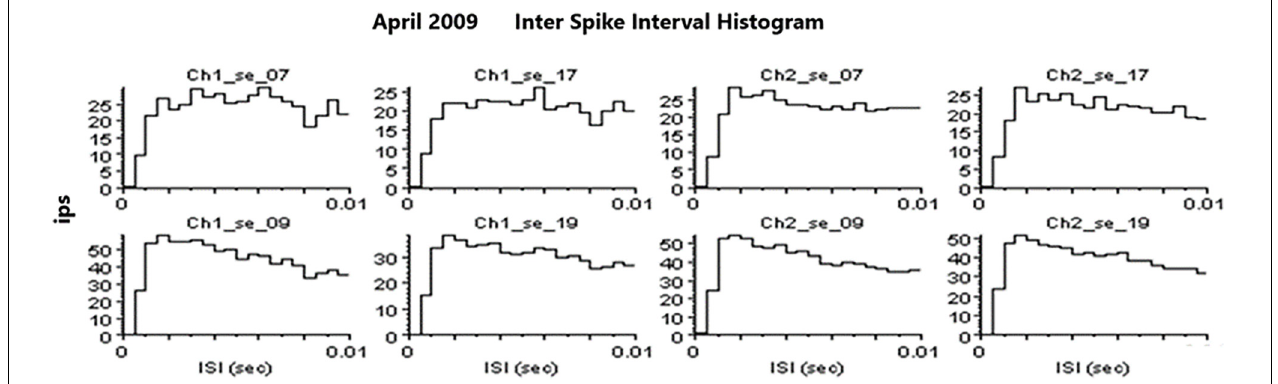
FIGURE 5 | Examples of inter spike interval histograms that identify SUs. Slow firing SU are not shown because they would have a “false gap” due to the slow firing rate.